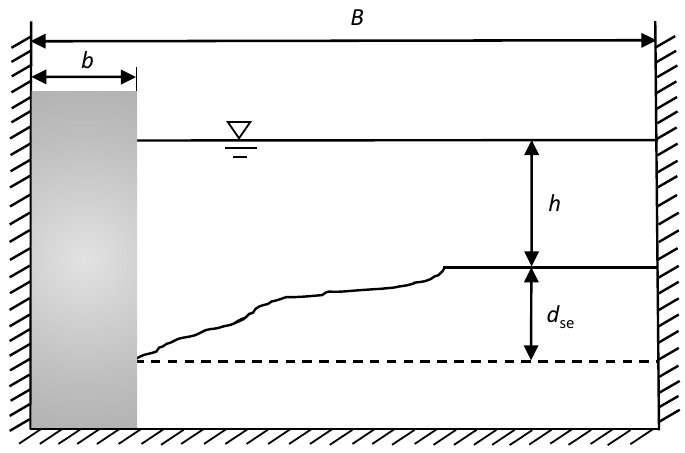
Figure 2. Schematic of abutment scour.